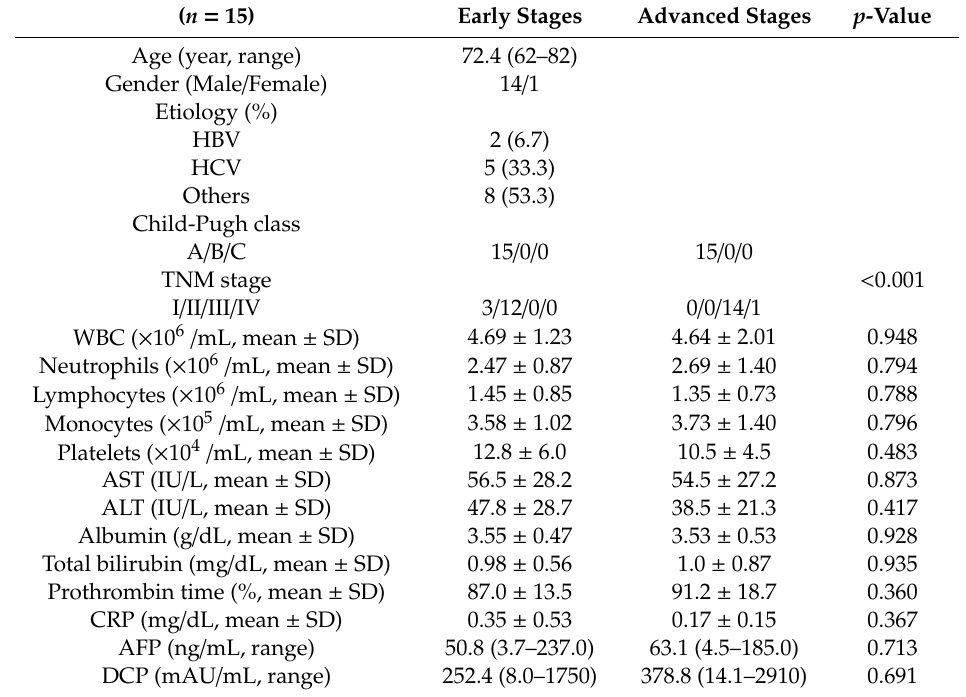
Table 1. Changes in the clinical characteristics of the same patients with early- and advanced-stage HCC.